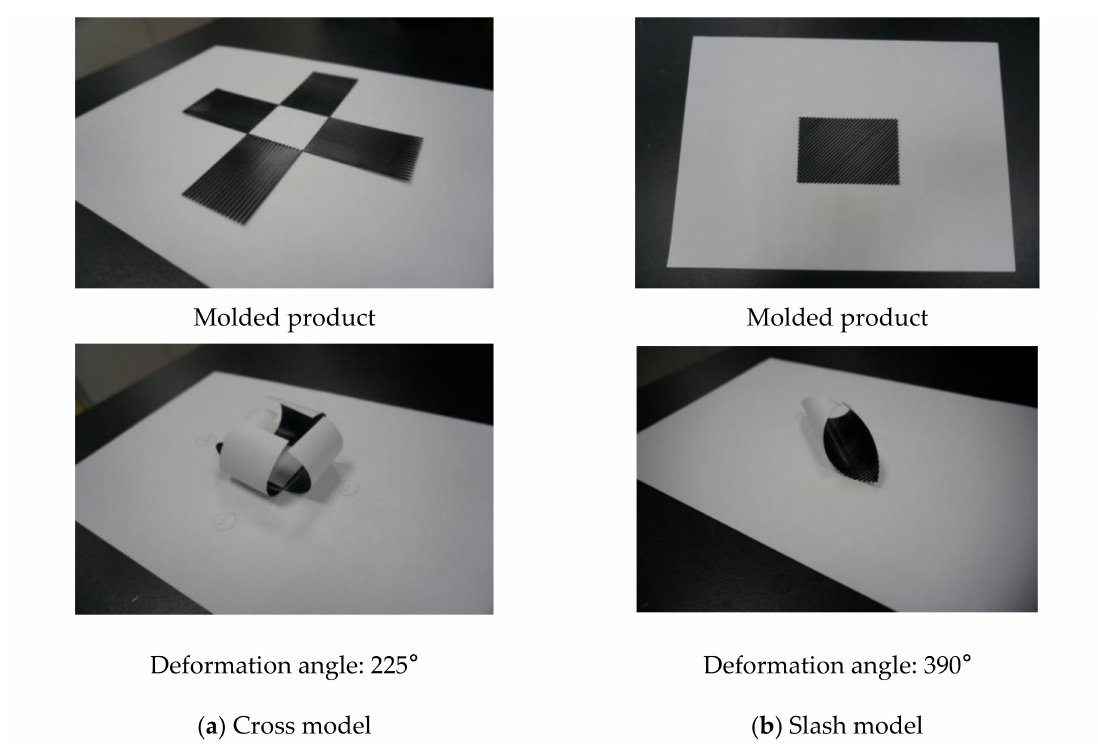
Figure 12. Deformation situations of the stimulus-responsive shape-memory composite material for various models (with a heating temperature of 185 ◦ C, heating time of 16